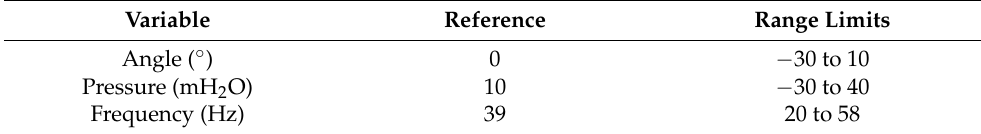
Table 10. Noises inserted into the soft sensor inputs: testing